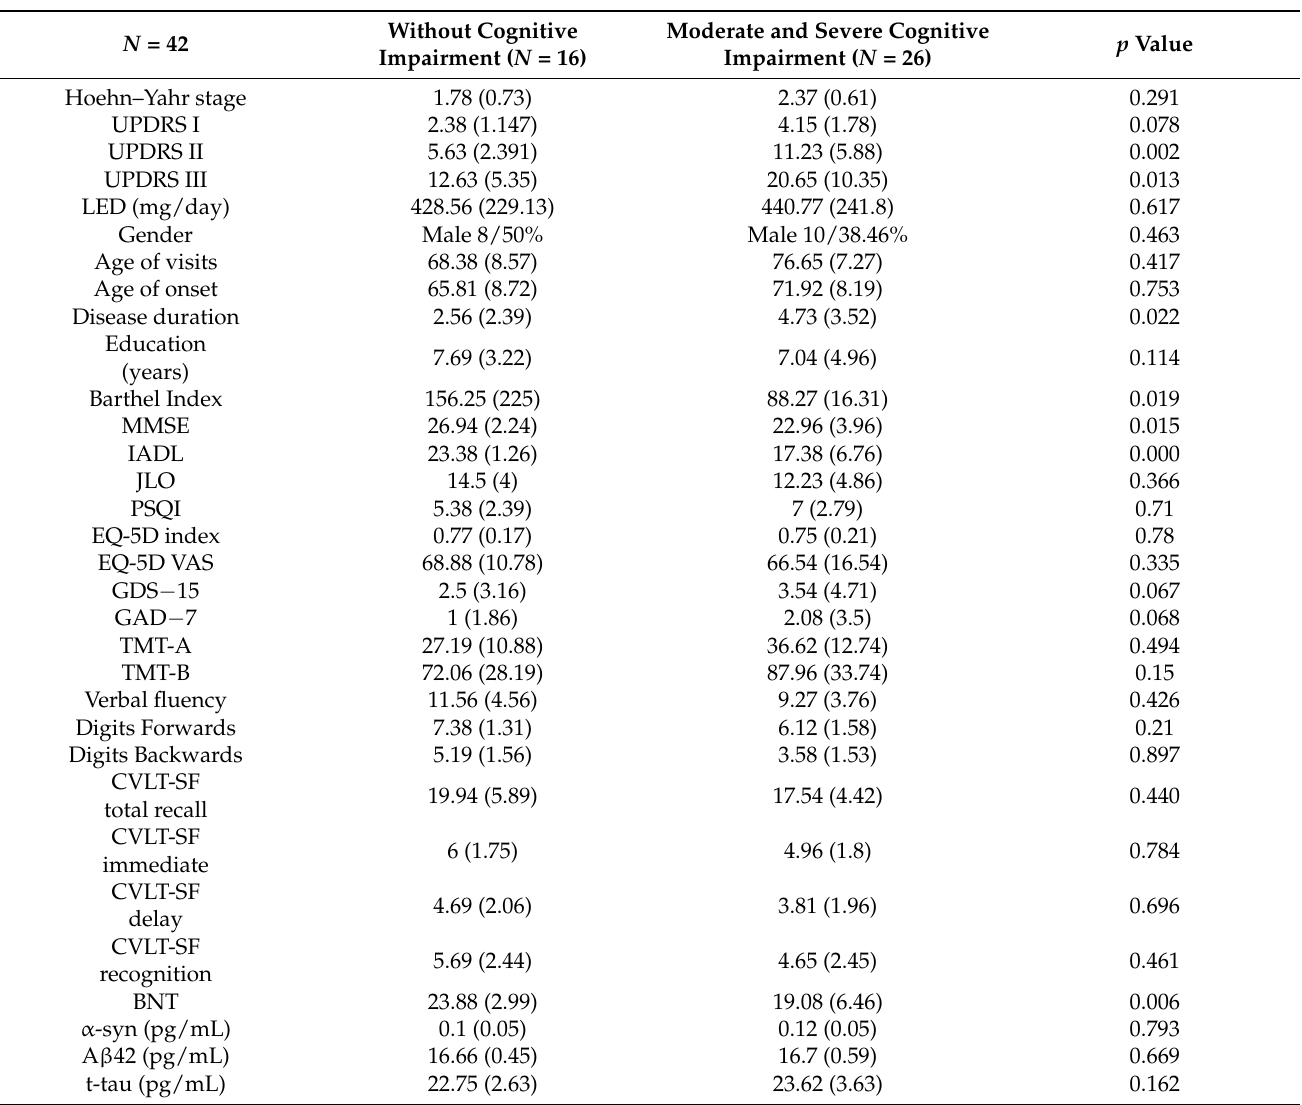
Table 2. The demographic and data comparisons of the participants.